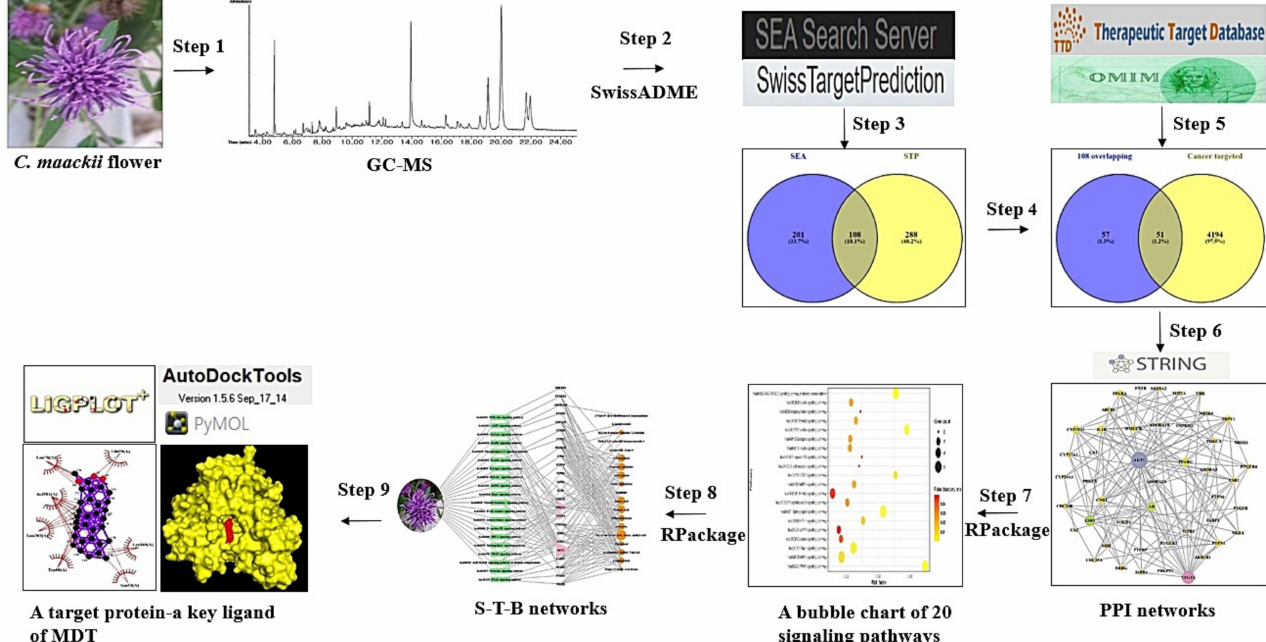
Figure 1. Workflow diagram of network pharmacology analysis of the C. maackii flower against cancer.